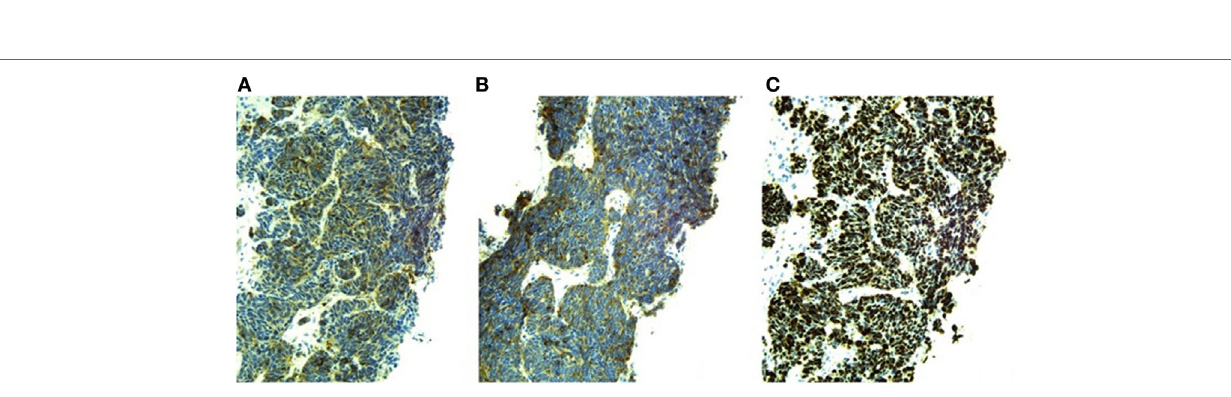
FIgURe 2 | Positive immunohistochemical stains and Ki-67 proliferation index of liver biopsy sample (20 × magnification). (a) Neuron-specific enolase. (B) Synaptophysin. (C) Ki-67 proliferation index 98%.